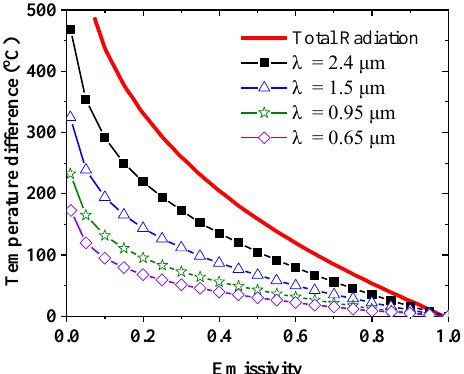
Figure 7. Temperature difference between the real temperature and the apparent temperature of the target surface at 1000 K with varied wavelength and emissivity [46]. Reprinted with permission from [46]. Elsevier, 2009.